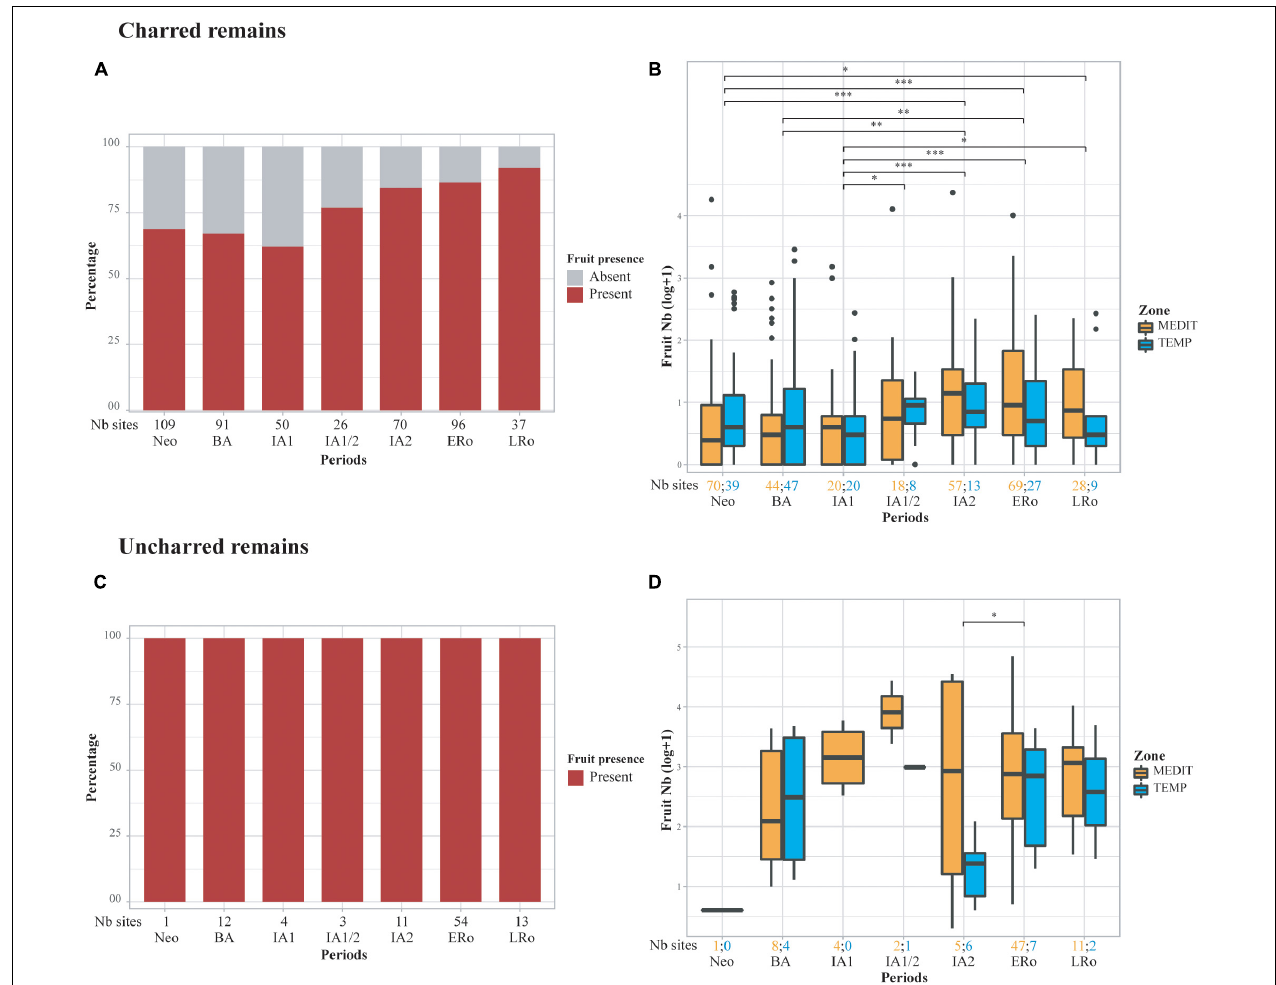
FIGURE 3 | Abundance of fruit remains in the archeological sites in relation to type of preservation and cultural periods, (A,B) charred remains, (C,D) uncharred remains, (A,C) stacked bar plots showing the proportion of sites with fruits, (B,D) box plots showing the distribution of log-transformed (log10) raw counts of fruits. Statistical significances of the Wilcoxon tests are indicated on the box plots, only when the result is significant (* p ≤ 0.05; ** p ≤ 0.01; *** p ≤ 0.001). The number of sites for each period and bioclimatic zone is provided at the bottom of the